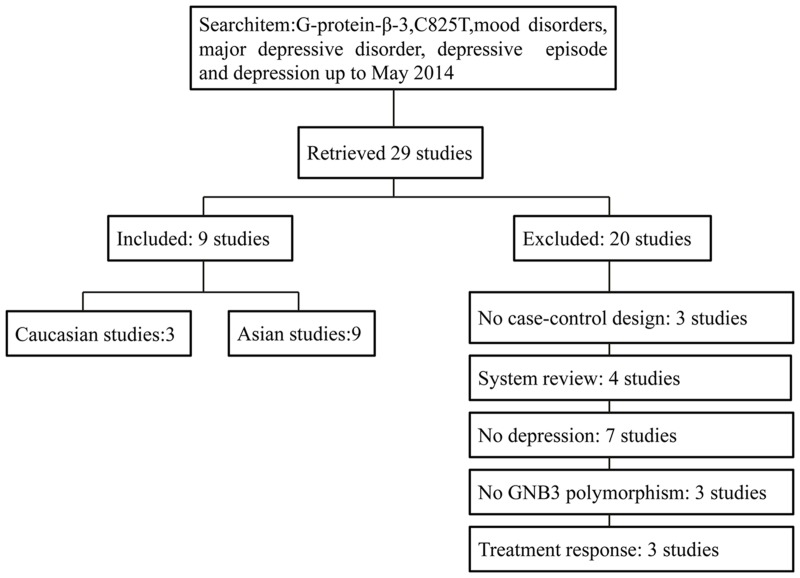
Flowchart of Study Selection.